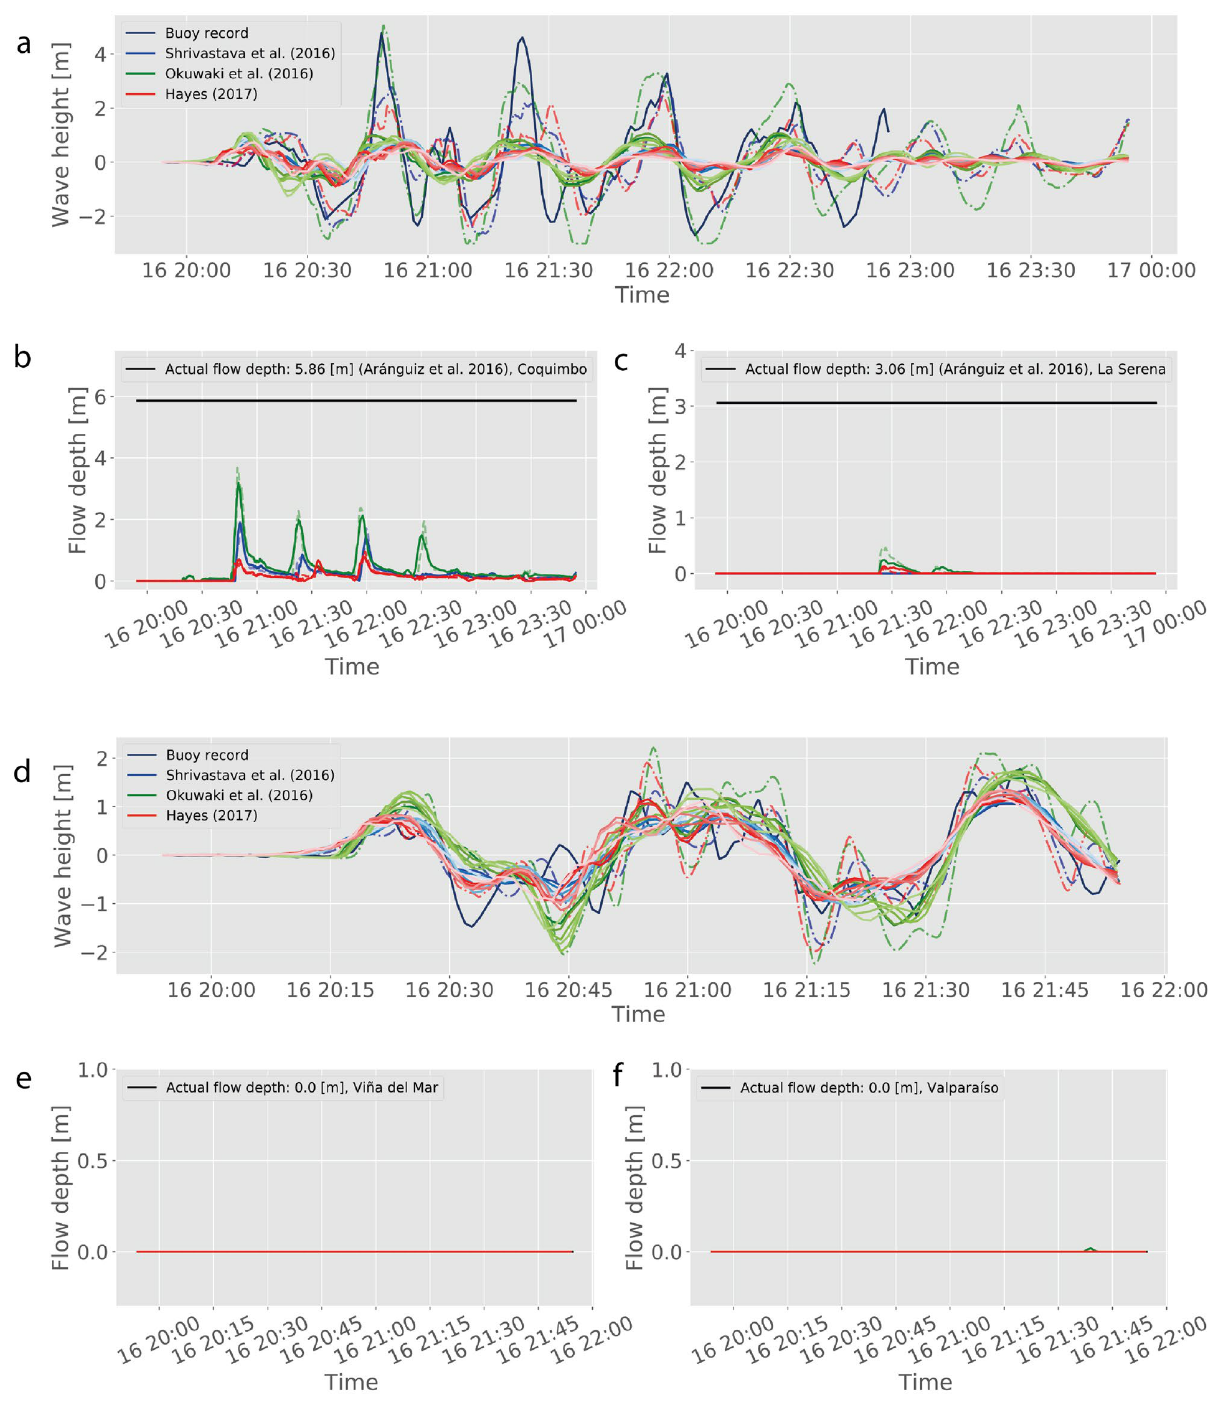
Figure 7. Results for the Illapel 2015 event. Same key as Fig. 6, with the exception of blue lines corresponding to Shrivastava et al. 74 , green lines to Okuwaki et al. 73 , and red lines correspond to Hayes 75 finite fault model (SRCMOD 71 and reference